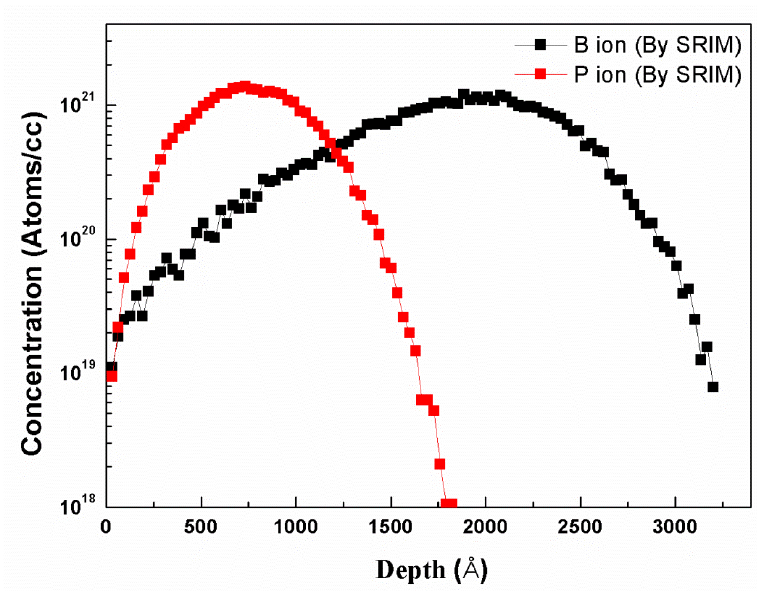
Figure 6. Simulation of B and P ion distribution by energy of 50 keV and dose of 1 × 10 16 cm −2 in polysilicon.